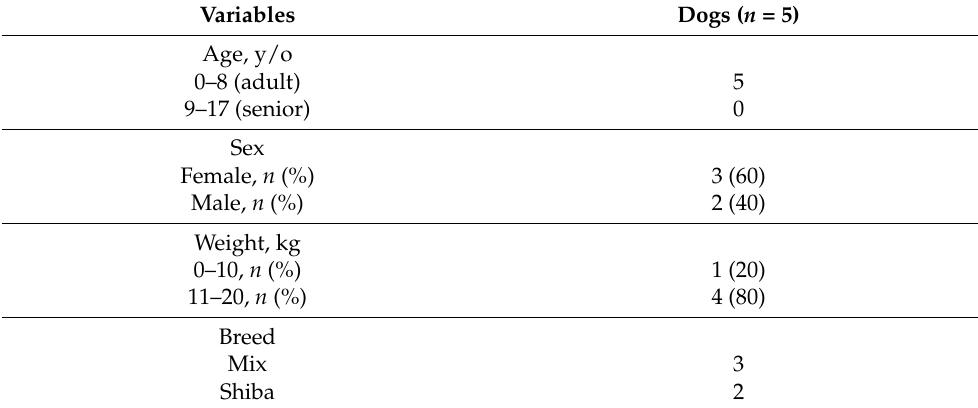
Table 1. Characteristics of the